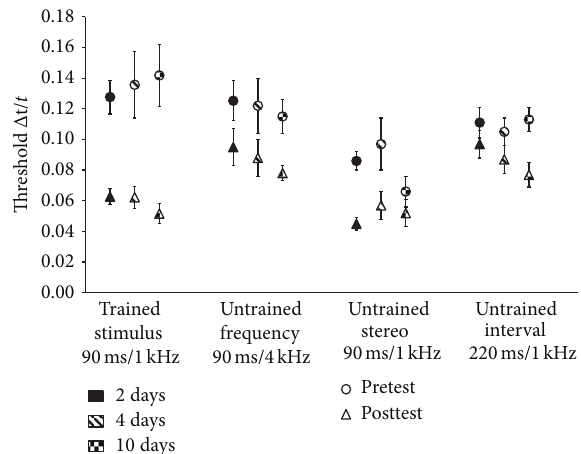
Figure 4: Mean temporal duration discrimination thresholds ( Δ t / t for 79% correct performance) for the trained interval (90ms/1kHz), untrained frequency (90ms/4kHz), untrained stereo (90ms/1kHz), and untrained interval (220 ms/1kHz). Circles represent pretest scores with triangles showing the posttest scores. Experimental groups are differentiated by colours (2d training, filled, 4d, diagonal stripes, and 10d, chequered). Error bars indicate ± 1SEM. All groups improvedoneachconditionfrompre-toposttest,buttherewasonly a significant group difference for generalization for the untrained duration condition where learning transfer was only found for the 10-day